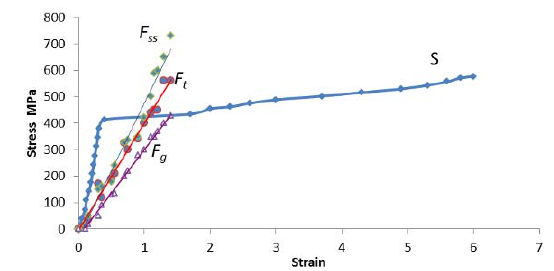
Figure 2. Stress-Strain curve for all the reinforcements involved in this